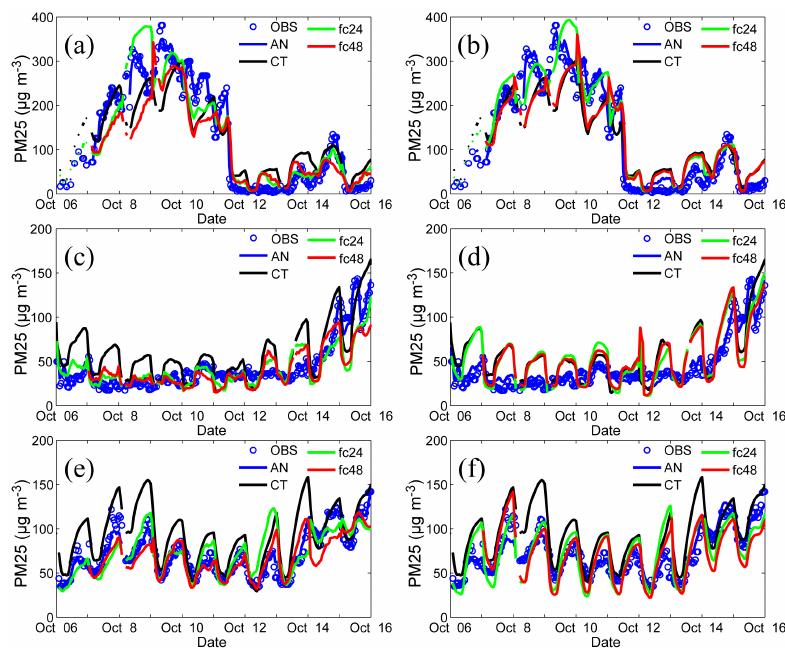
Figure 9. Time series of the hourly PM 2 . 5 obtained from observations (circle), analysis (blue line), control run (black line) and hourly output of 48h forecast in three megacities: (a) Beijing, (c) Shanghai and (e) Guangzhou in expJ and (b) Beijing, (d) Shanghai and (f) Guangzhou in expC. See text in Sect.